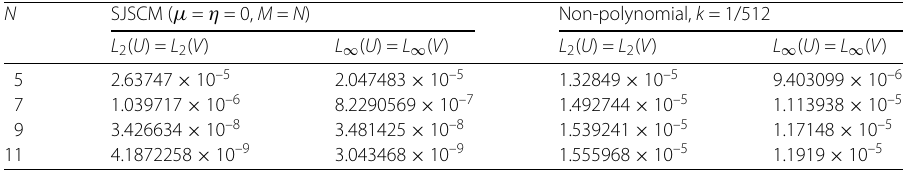
Table 12 L 2 and L ∞ error norms for u ( x , t ) = v ( x , t ) of Example 2 when 0 ≤ x ≤ 3, α 1 = α 2 = 0.4